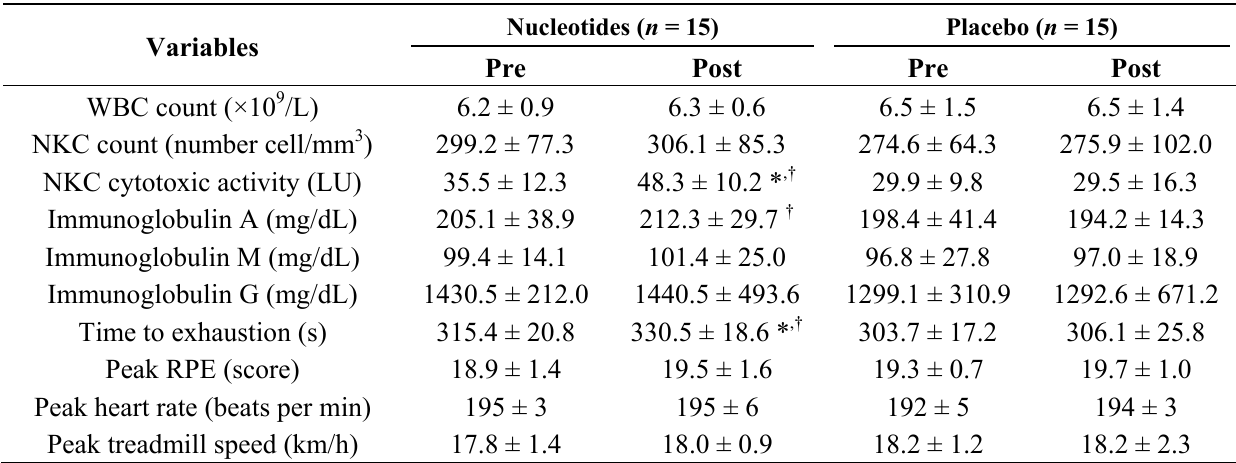
Table 2. Immunological and exercise performance variables in nucleotides and placebo trials.